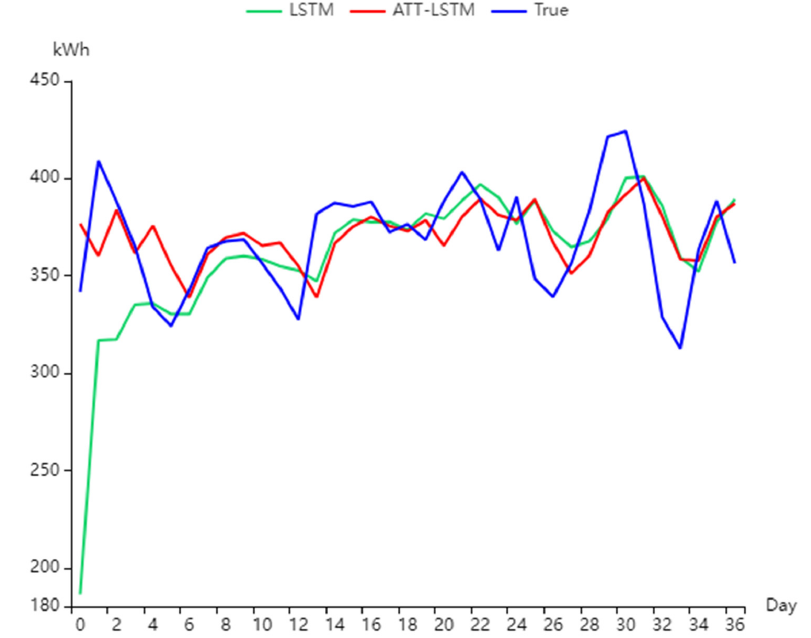
Figure 11. Comparison of predicted values of the ATT-LSTM prediction model, the LSTM prediction model and the true